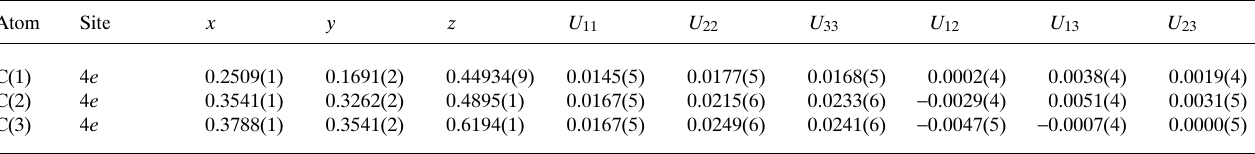
Table 3. Atomic coordinates and displacement parameters (in Å 2 ) .